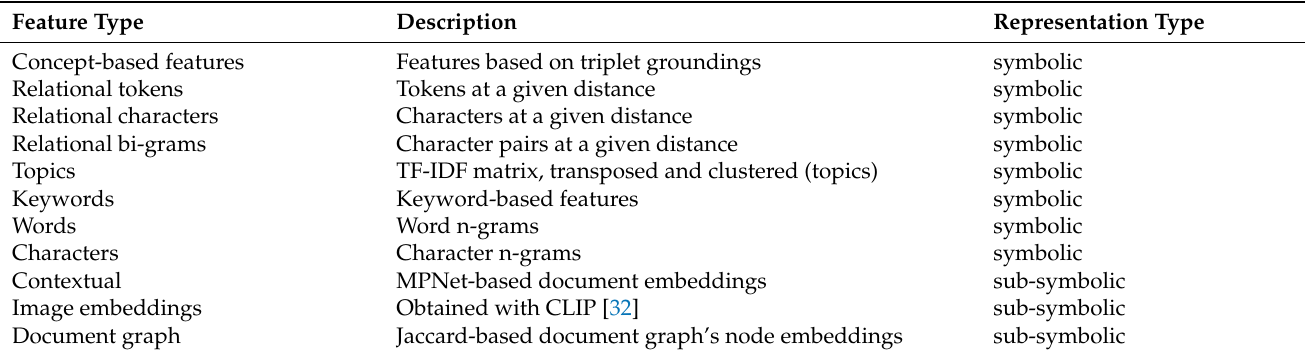
Table 1. Representations of documents and images considered by